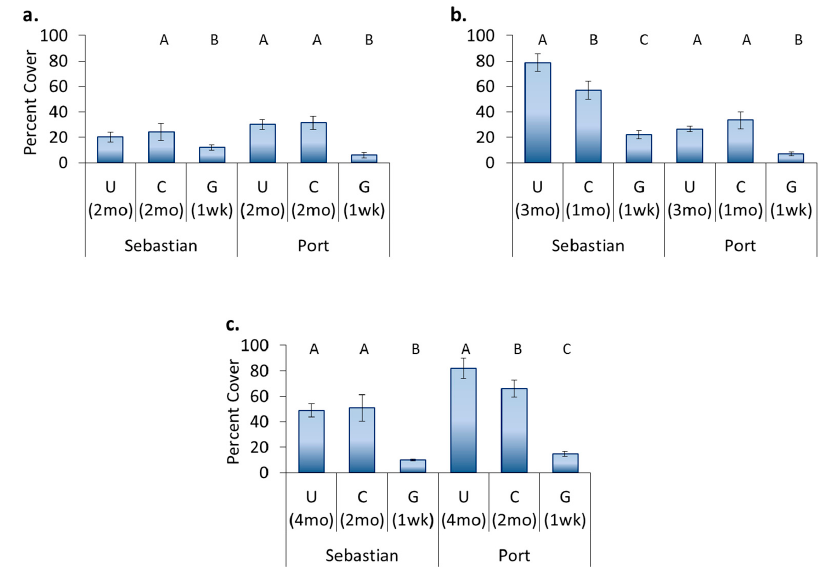
Figure 7. Differences in average total macrofouling cover on IS900 due to treatment. ( a ) In May in Sebastian, cleaned panels had higher cover of macrofouling than groomed panels ( p < 0.01). In Port Canaveral, groomed panels had significantly lower cover than uncleaned and cleaned ones ( p < 0.001). ( b ) In June in Sebastian, uncleaned panels had significantly higher cover than cleaned ( p = 0.004) and groomed ( p < 0.001) panels; cleaned panels had significantly higher cover than groomed ( p < 0.001) panels. In Port Canaveral, groomed panels had significantly lower cover than uncleaned ( p = 0.001) and cleaned ( p < 0.001) panels. ( c ) In July in Sebastian, groomed panels had significantly lower cover than uncleaned or cleaned ( p < 0.001) panels. In Port Canaveral, uncleaned panels had significantly higher cover than cleaned ( p = 0.006) and groomed ( p < 0.001) panels; cleaned panels had significantly higher cover than groomed panels ( p < 0.001). Error bars represent one standard error. The X-axis is treatment and the Y-axis is average percent cover. Treatments are uncleaned (U), cleaned (C) and groomed (G). The time in the parenthesis is elapsed time since treatment. Letters above the bars denote statistical significance (i.e., As are statistically similar to, but significantly different than Bs).